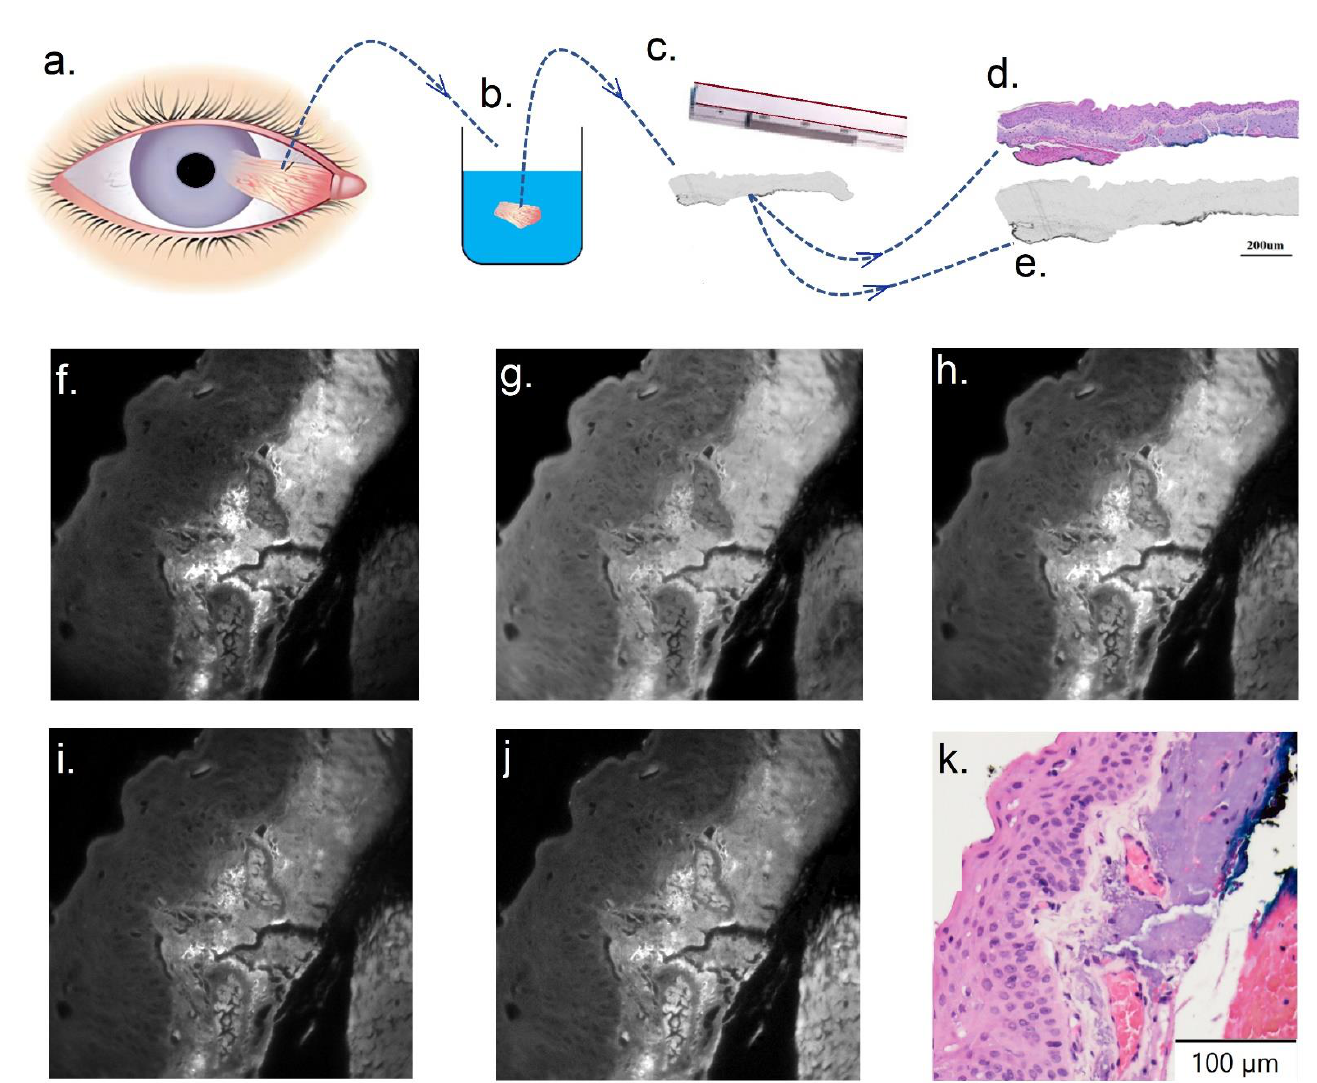
Figure 2. ( a – e ) Sample preparation and histological assessment. ( a ) Ocular surface biopsy collected from patients. ( b ) Histology sample processed following formalin fixation into paraffin embedded sections. ( c ) Two adjacent sections were cut using a microtome and then dewaxed. ( d ) Example cut tissue section, which was H&E stained and coverslipped for histology assessment and used as reference. ( e ) The unstained tissue section adjacent to that shown in ( d ). Such sections were placed on a slide, coverslipped, and used for multispectral imaging analysis. ( e – j ) Example tissue images in selected channels (channels number 3, 16, 22, 31, and 45, respectively). ( k ) H&E stained section of